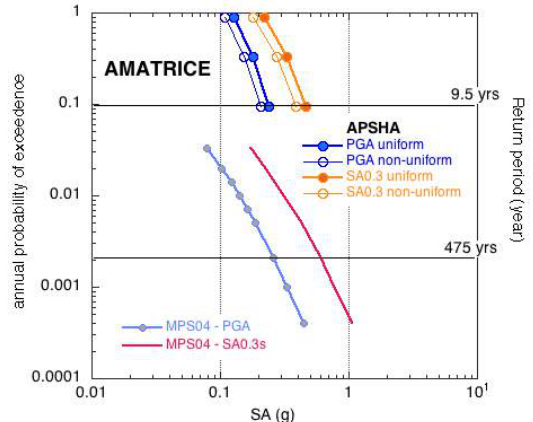
Figure 6: hazard curves in